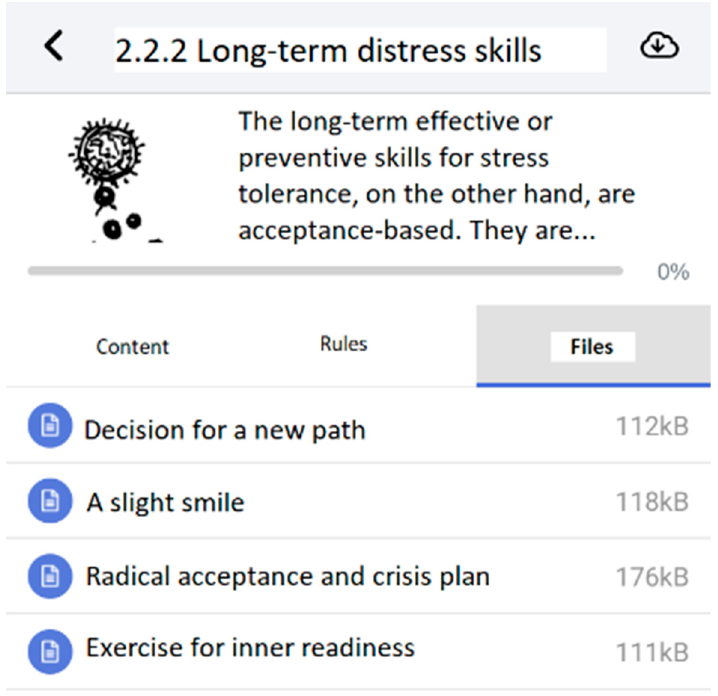
Figure A2. Tab “Content”.